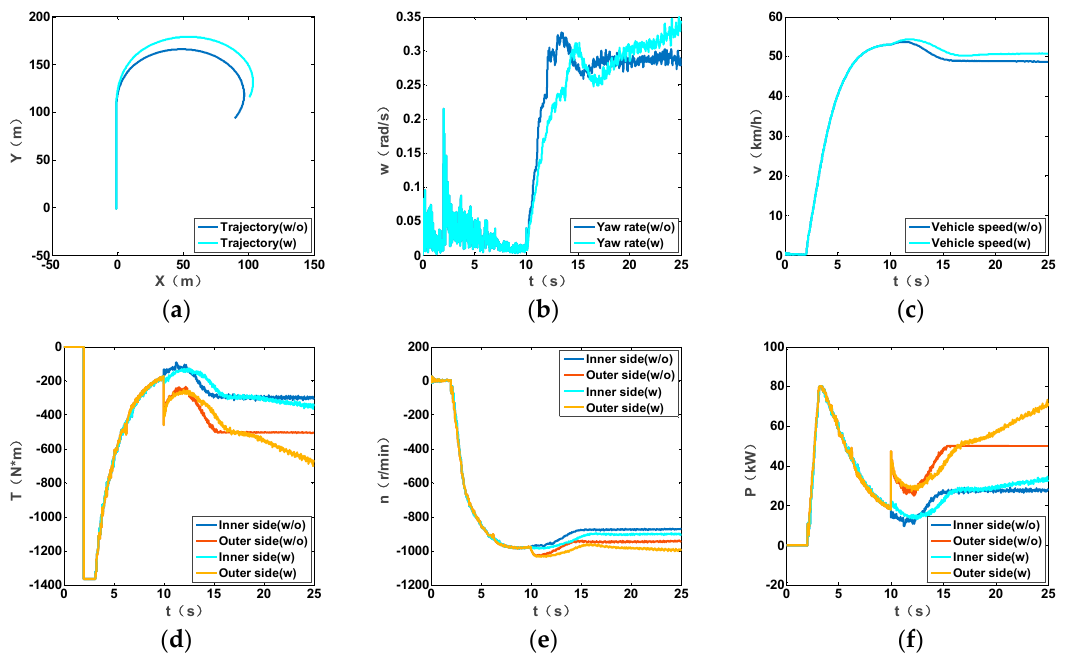
Figure 10. Simulation results of 5 B steering: ( a ) Trajectory; ( b ) Vehicle yaw rate; ( c ) Vehicle speed; ( d ) Sprocket torque; ( e ) Sprocket rotation speed; ( f ) Sprocket power.